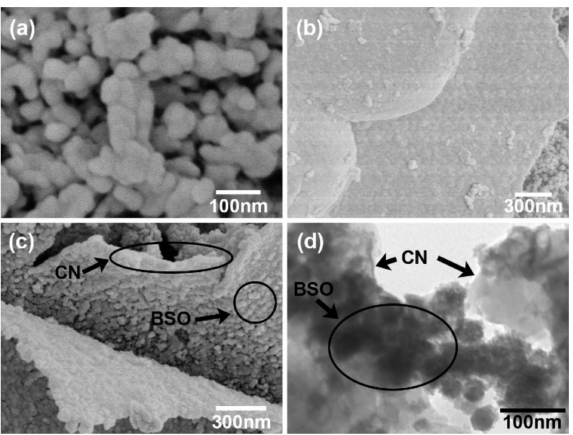
Figure 4. SEM patterns of BSO sample ( a ), CN sample ( b ), and BSCN sample ( c ); and TEM pattern of BSCN sample ( d